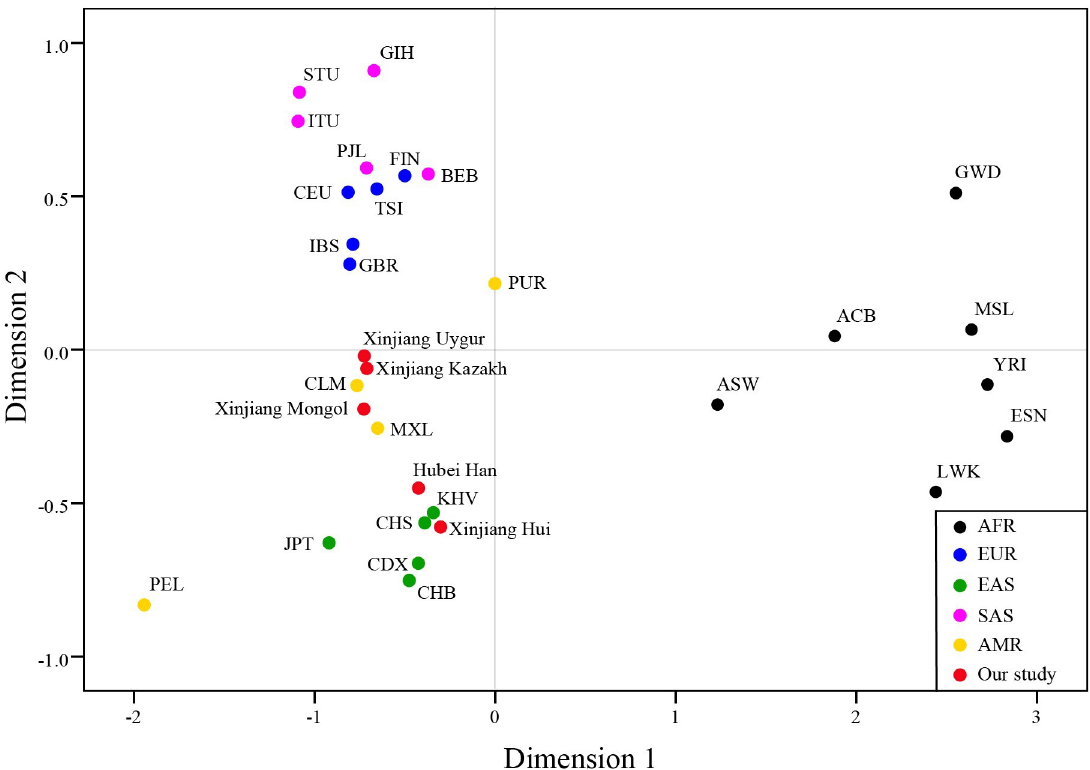
Fig 4. Multi-dimensional scale analysis of the 31 populations based on D A